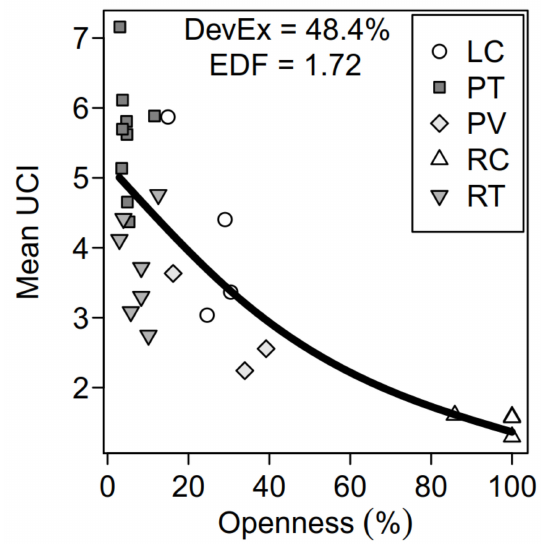
Figure 9. Relationship between mean canopy openness and mean understory layer complexity (UCI) for all sample plots. EDF = effective degrees of freedom. Bold line: visualization of the fitted GAM